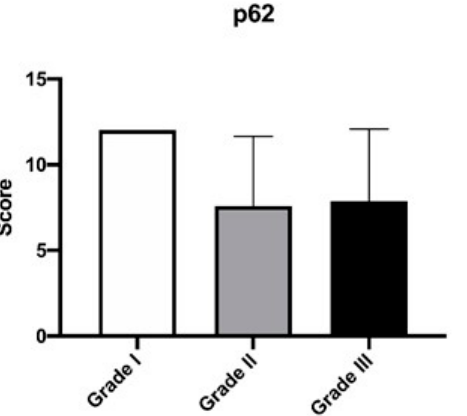
Figure 3. Mean (±SD) of the immunoreactivity score for p62 in the cases of feline mammary carcinoma with different grades of differentiation. Table 2. Immunoreactivity score for p62 in cases with lymphovascular invasion. Cases with Lymphovascular Invasion and p62 Immunoreactivity